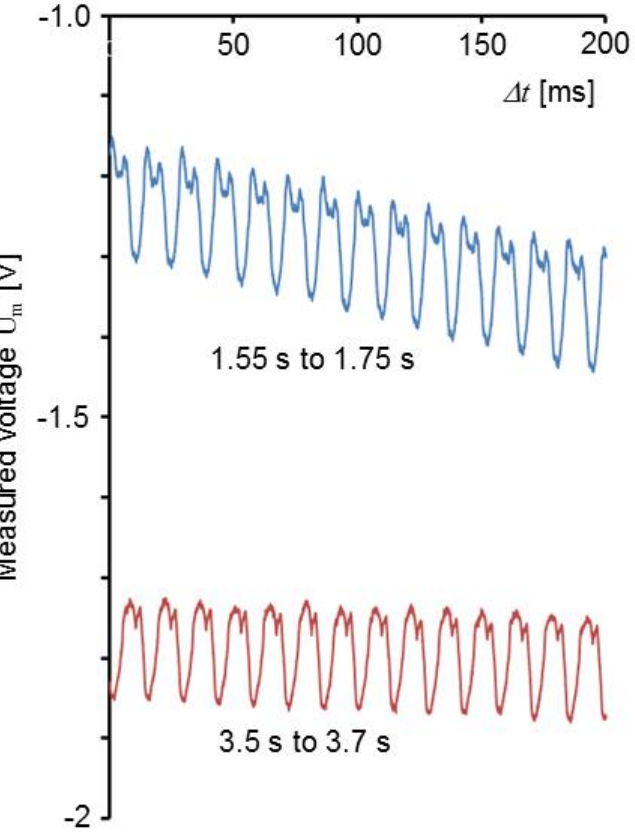
Figure 19. Voltage measured as shown in Figure 18 at begin and end of machine movement. The corresponding time range from Figure 18 is shown next to the curves.